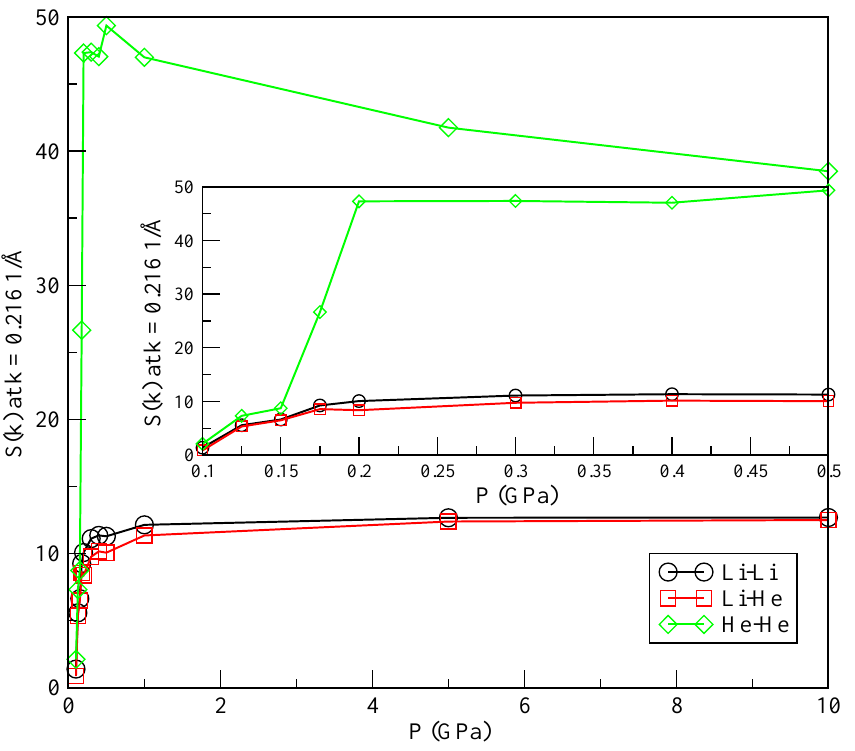
Figure 8. Static structure factors computed at very low momentum ( k = 0.2161/Å) a function of the pressure. Li-Li (black circles); Li-He (red squares); He-He (green diamonds).